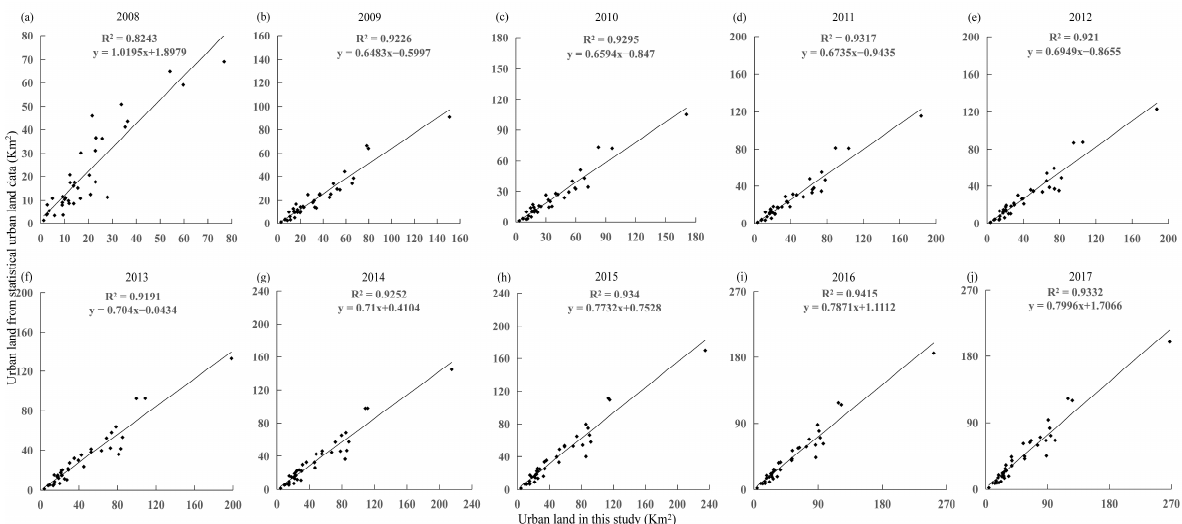
Figure 5. The results of the built-up area extracted in this paper are compared with statistical data.